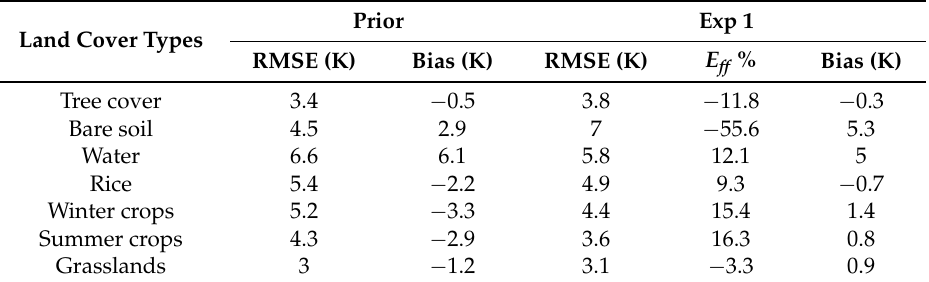
Table 6. GPS downscaling results by class averaged over the seven considered validation dates at 60 m resolution, compared to SETHYS prior